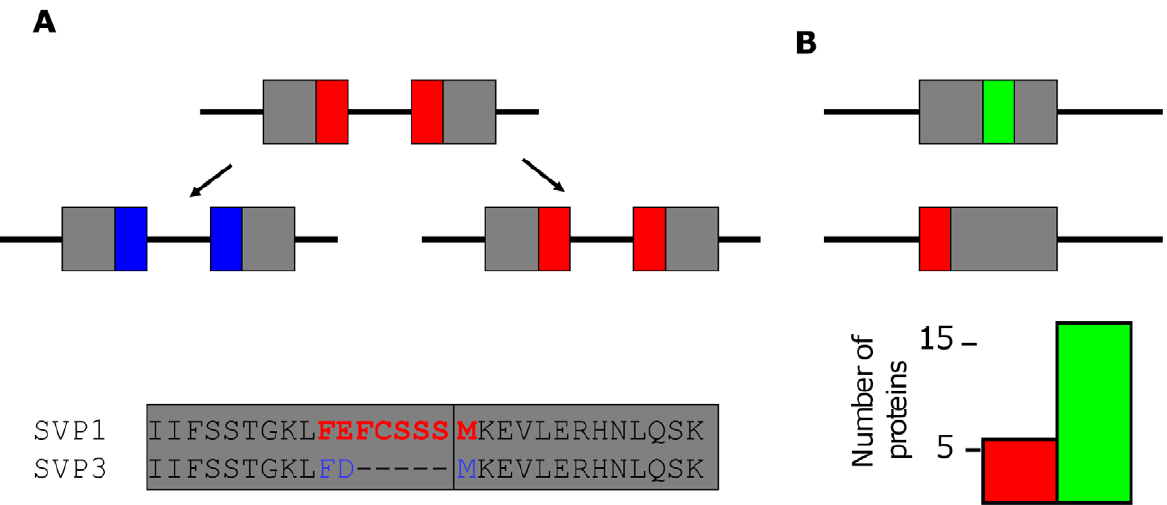
Figure 5. Mechanism of generating protein-protein interaction diversity by shifting intron/exon borders. ( A ) After a duplication of a gene or in the case of alternative splicing, a shift of an intron/exon border can modify a protein interaction motif which overlaps or is close to such a border. Top panel, schematic illustration of this process. Line indicates gene sequence, grey bars indicate exons, and colored bars indicate predicted interaction motifs. Bottom panel , part of a protein sequence alignment for the Arabidopsis MADS domain protein SHORT VEGETATIVE PHASE (SVP1) and an identified alternatively spliced SVP form named SVP3. A predicted interaction motif in SVP1 which is almost completely spliced out in SVP3 is shown in red. Two grey bars indicate the two adjacent exons. ( B ) Predicted interaction motifs can be either close to an intron/exon border (indicated by red motif) or far away from the intron/exon border (green motif). Bars in the graph indicate average number of Arabidopsis MIKC MADS proteins in which predicted interaction motifs occur for two different motif groups: motifs that are located close to the intron/exon border ( , 3 amino acids distance, red) occur on average in a few proteins only, and motifs that are located far away from the border ( . =3 amino acids distance, green) occur in many